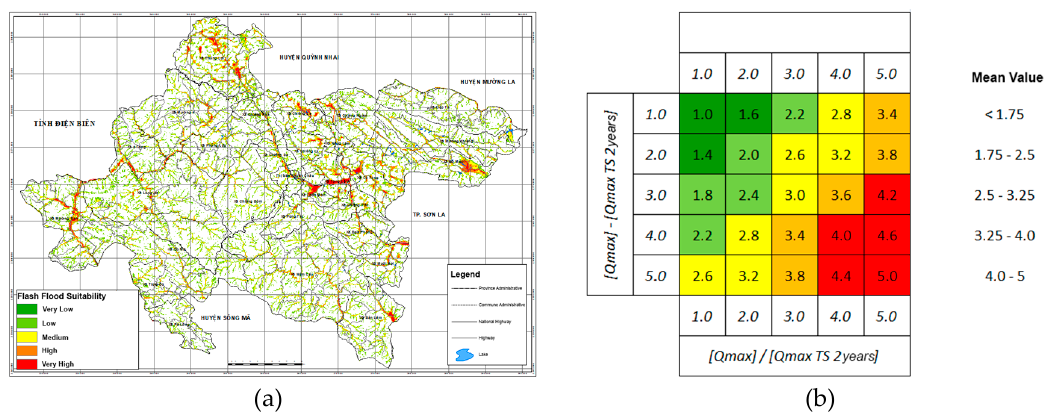
Figure 4. (a) Flash flood risk map and (b) flash flood risk information (FFPI) for each pixel. Figure 4. ( a ) Flash flood risk map and ( b ) flash flood risk information (FFPI) for each pixel.